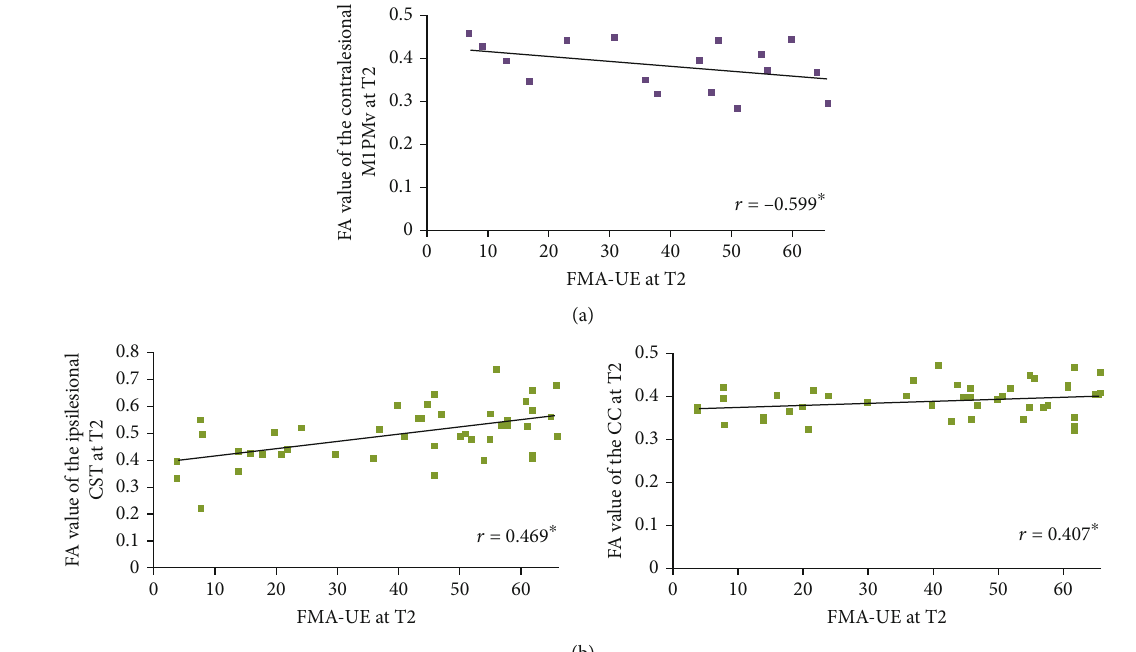
Figure 4: Correlations between upper limb motor function at three months after stroke and tract-related fractional anisotropy at three months after stroke in (a) valine (Val) homozygotes and (b) methionine (Met) allele carriers of BDNF genotype. “ r ” represents the partial correlation coe ffi cient. Asterisks indicate signi fi cant di ff erences ( ∗ P < 0 : 05 ). CC: corpus callosum; CST: corticospinal tract; FA: fractional anisotropy; FMA-UE: Fugl-Meyer assessment, upper extremity; M1PMv: intrahemispheric corticocortical connection from the primary motor cortex to the ventral premotor cortex; r : partial correlation coe ffi cient; T1: two weeks after stroke onset; T2: three months after stroke onset. Table 2: Partial correlation adjusted by age, stroke lesion volume, and severity of initial motor impairments between tract-fractional anisotropy at T2 and upper limb motor impairments at T2 in patients with the valine homozygotes of the BDNF genotype (Val group) and methionine allele carriers of BDNF genotype (Met group).